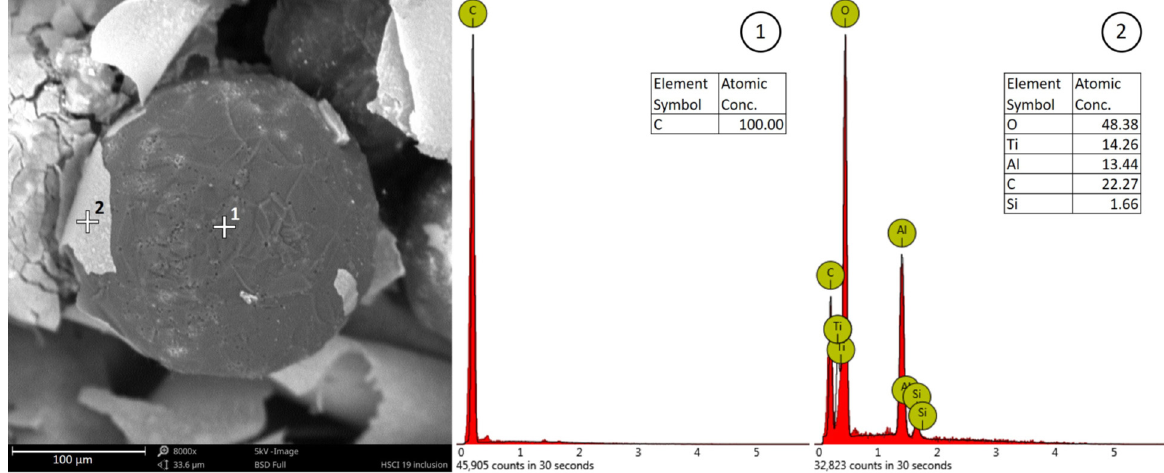
Figure 5. Chemical content local analysis of the dark extrusion ( 1 )–graphite, and the light extrusion ( 2 )–bifilm.